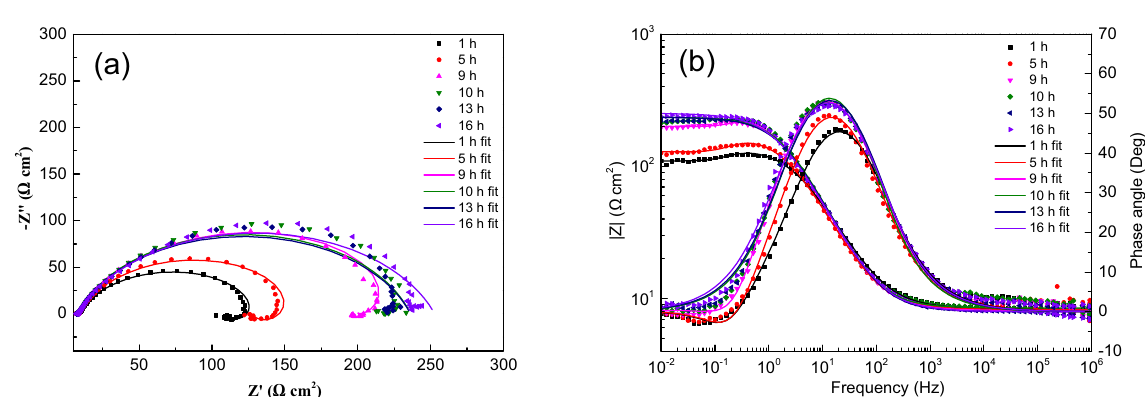
Figure 5. EIS spectra for sample with ADP under static liquid film, h = 4.5 mm: ( a ) Nyquist plots, ( b ) Bode and |Z| plots.